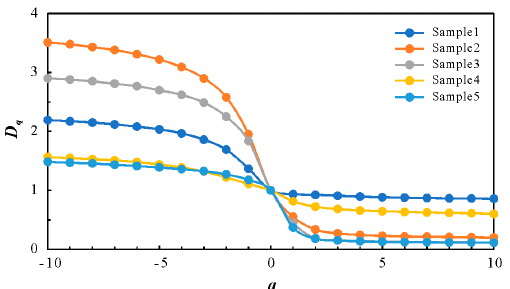
Figure 7. Generalized multifractal dimension spectra.